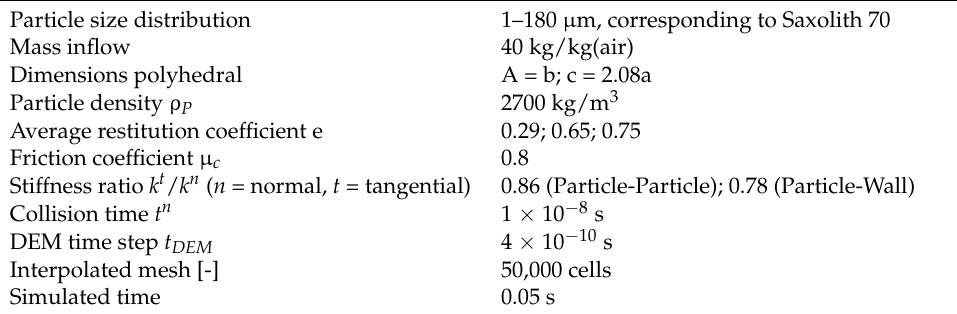
Figure A3. Surface height profile of the used impaction plates, measured with a white light interfer- ometer (Sensor: WLI PL, FRT GmbH).